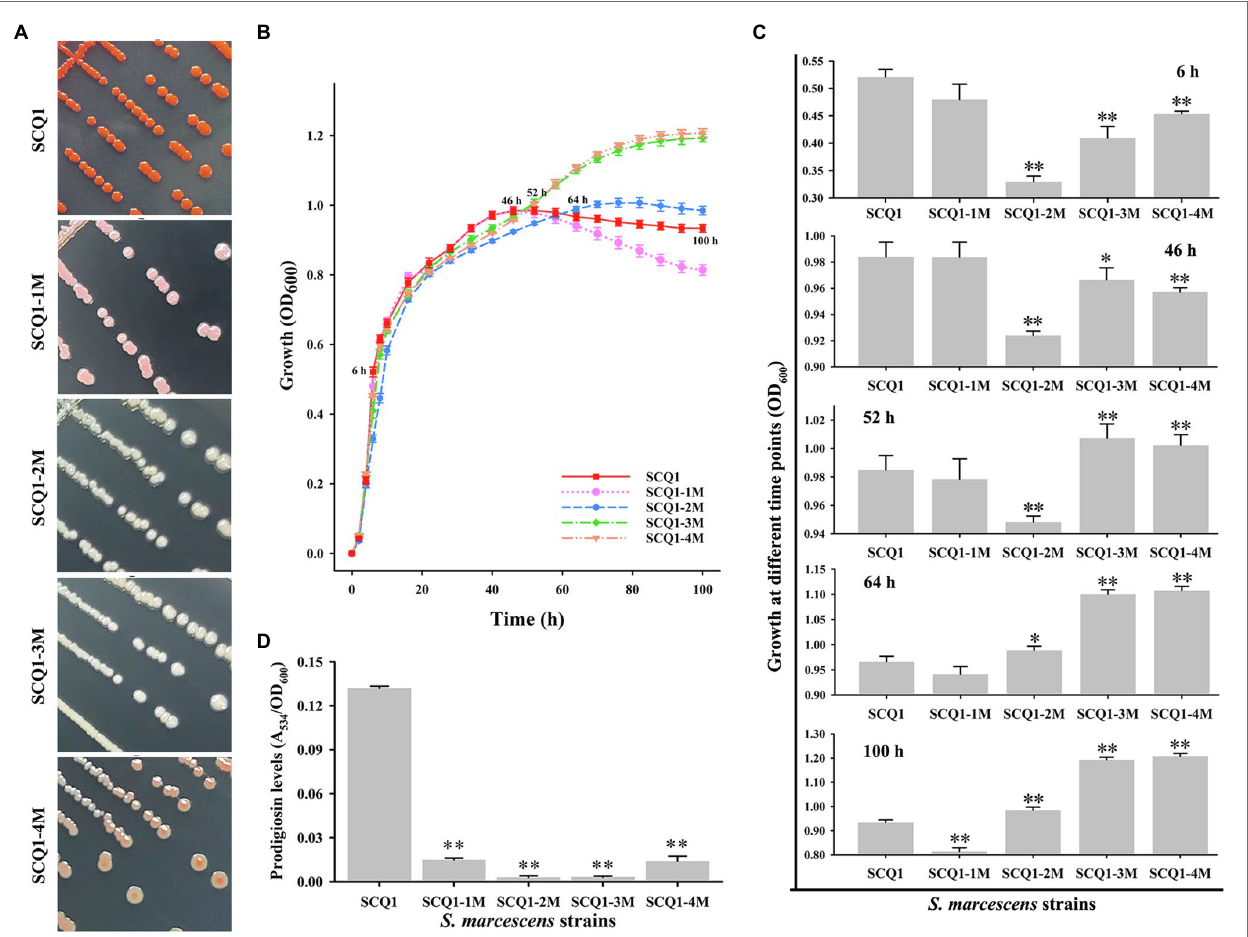
FIGURE 2 | The phenotypic patterns of wild-type S. marcescens and its spontaneous mutants. (A) The colony of the wild-type strain SCQ1 and the four mutants on LB plate. (B) Growth of different S. marcescens strains in LB medium. The OD 600 values are monitored every 2 h for 100 h using the Bioscreen C instrument with three technical replicates. Different lines and symbols represent different bacterial strains. The data are expressed as mean ± SD. Several time points are labeled and the details are shown in (C) . (D) The relative prodigiosin production in different S. marcescens strains is measured after 16 h incubation at 28°C. The values are calculated and expressed as mean ± SD ( n = 3, * p < 0.05, ** p <